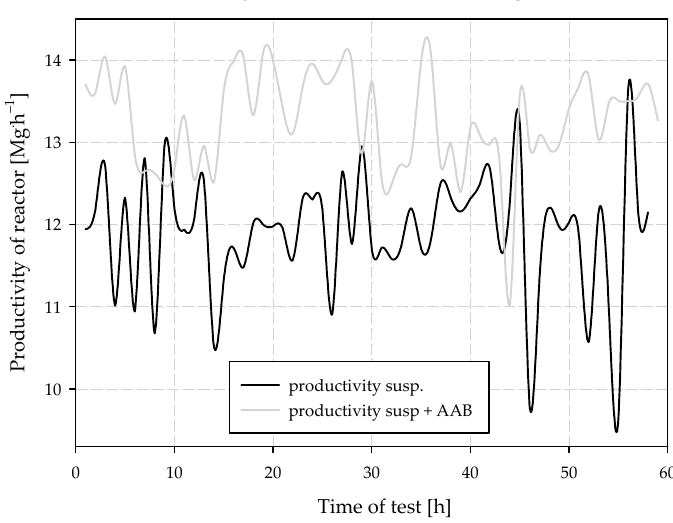
Figure 19. Productivity of reactor with and without dosing of AAB .